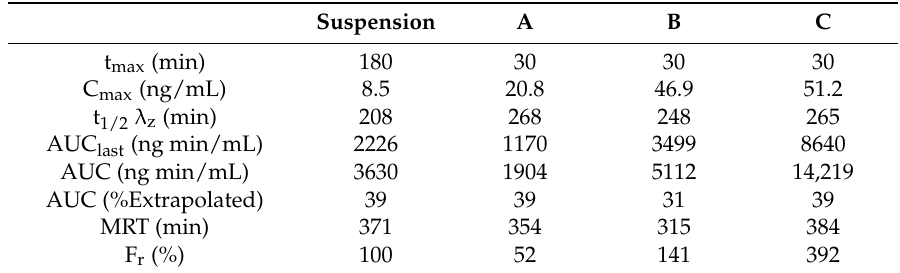
Table 4. Non-compartmental pharmacokinetic parameters of berberine following oral administration in Balb/c